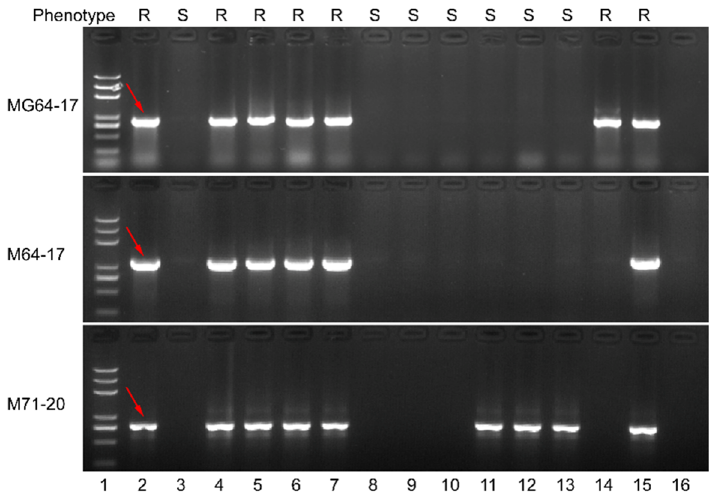
Figure 7. Detection of MG64-17, M64-17and MG71-20 in 12 S. chacoense lines. Lanes 1-16: Trans2K®Plus DNA Marker; S. chacoense accession 40-3; S. berthaultii accession 143-6; M6; CHC524-8; CHC524-8-1; CHC524-8-2; CHC54-1; CHC54-2; CHC54-3; CHC55-1; CHC55-2; CHC55-3; CHC39-7; C545; no template control. One of the specific bands that can be amplified only in resistant accessions are indicated with red arrows.